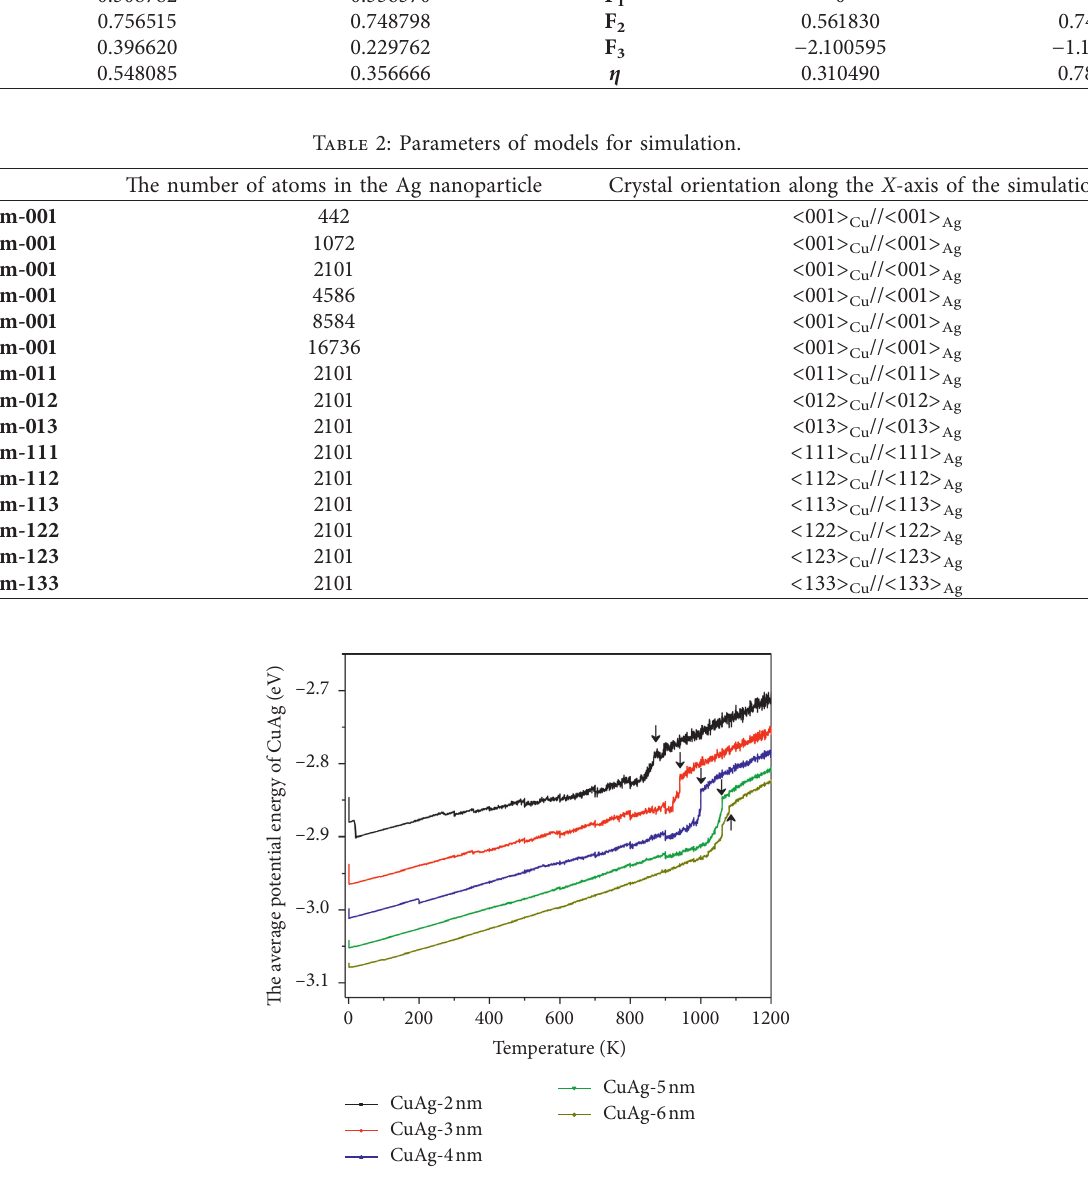
Figure 1: Potential energy per atom versus temperature.